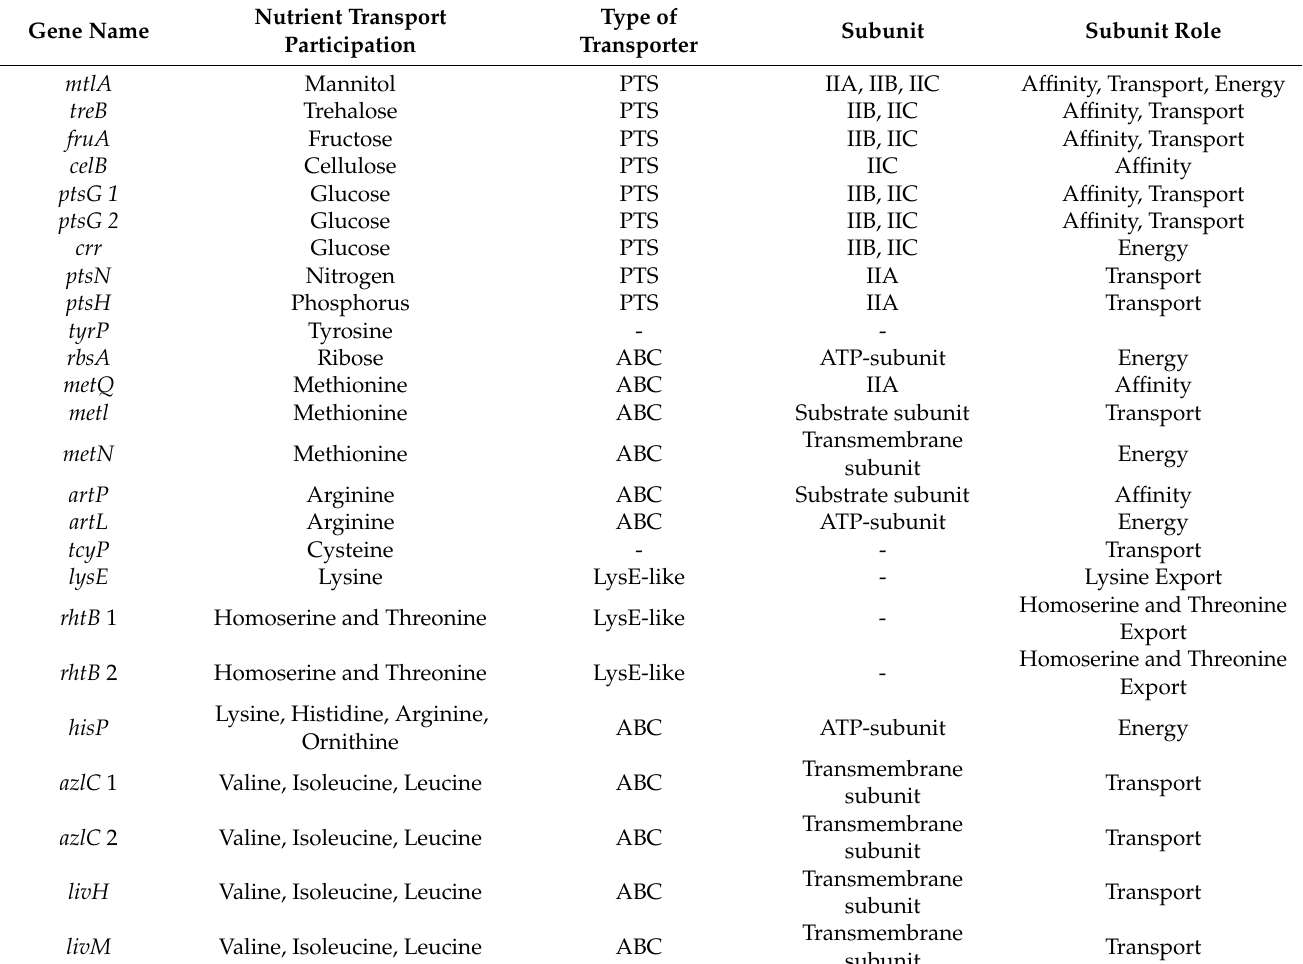
Table 3. Main characteristics of the inner membrane-related proteins that were studied in phage-susceptible and phage- resistant